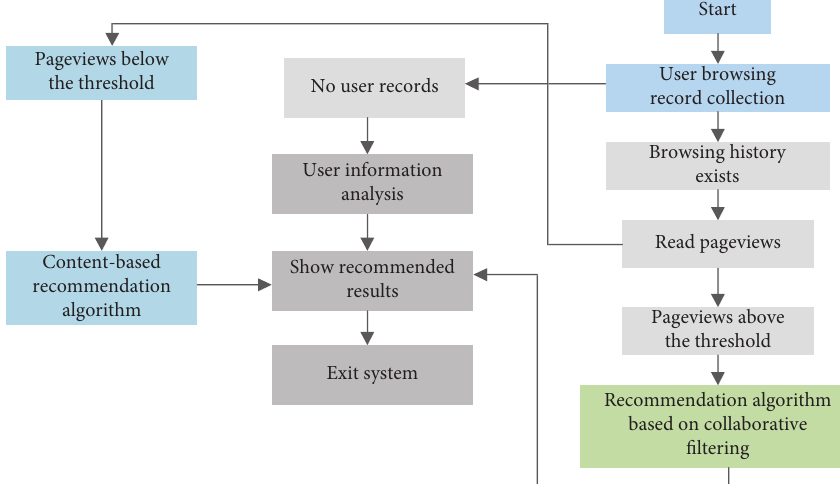
Figure 3: Schematic diagram of the recommendation system based on collaborative